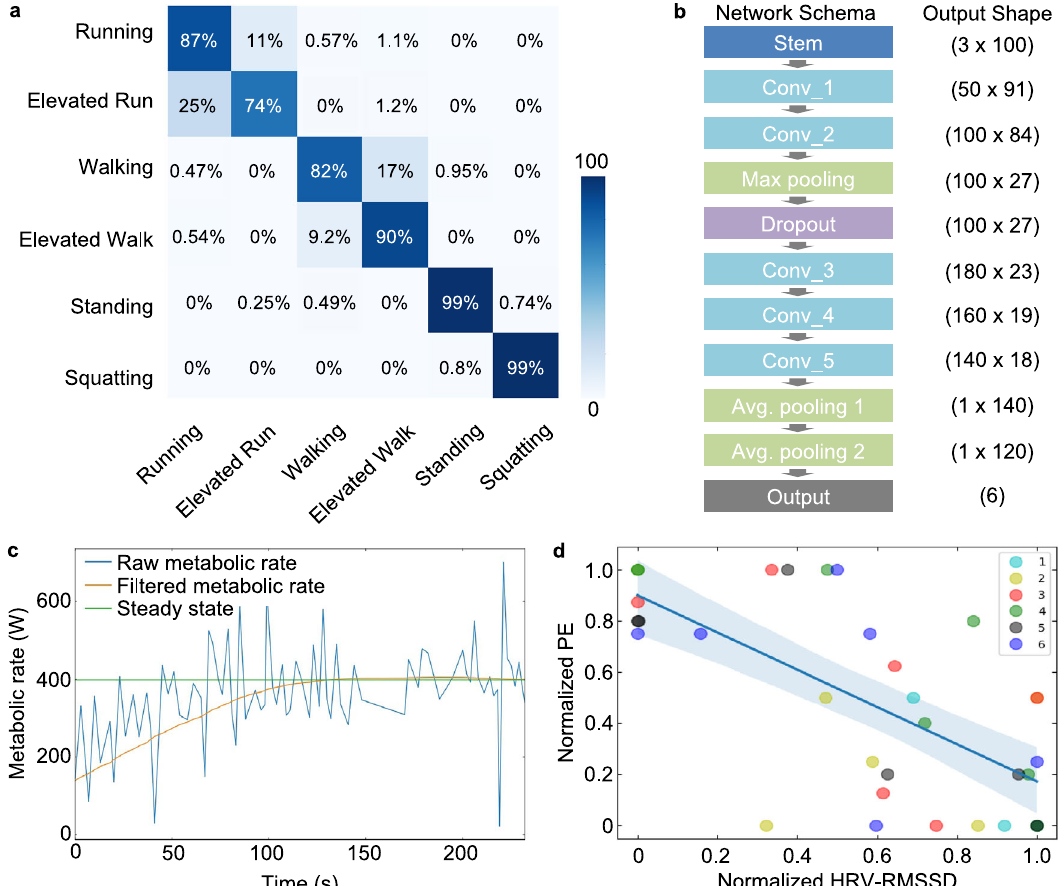
Fig. 5 Data classi fi cation via machine learning and estimation of metabolic costs and physical effort. a A confusion matrix showing data from the IMU sensor classifying six different motions (running, elevated running, walking, elevated walking, standing, and squatting) with an overall accuracy of 88%. b Flow chart representing a spatial CNN model with fi ve layers of convolutions with fi lters of decreasing the dimension size and two layers of average pooling. c Metabolic rate from oxygen intake and carbon dioxide exhale measured with the calorimetric respiratory mask. Raw data are fi ltered with a bandpass fi lter, and steady-state values are used to compare with normalized HRV- RMSSD. d Normalized physical effort (PE) compared with normalized HRV-RMSSD where PE represents the quantitative description of hardness for each trial by subjects measured using the Borg perceived exertion scale (6 – 20). The measured Pearson R correlation is − 0.689 ( p -value: 6.6e −